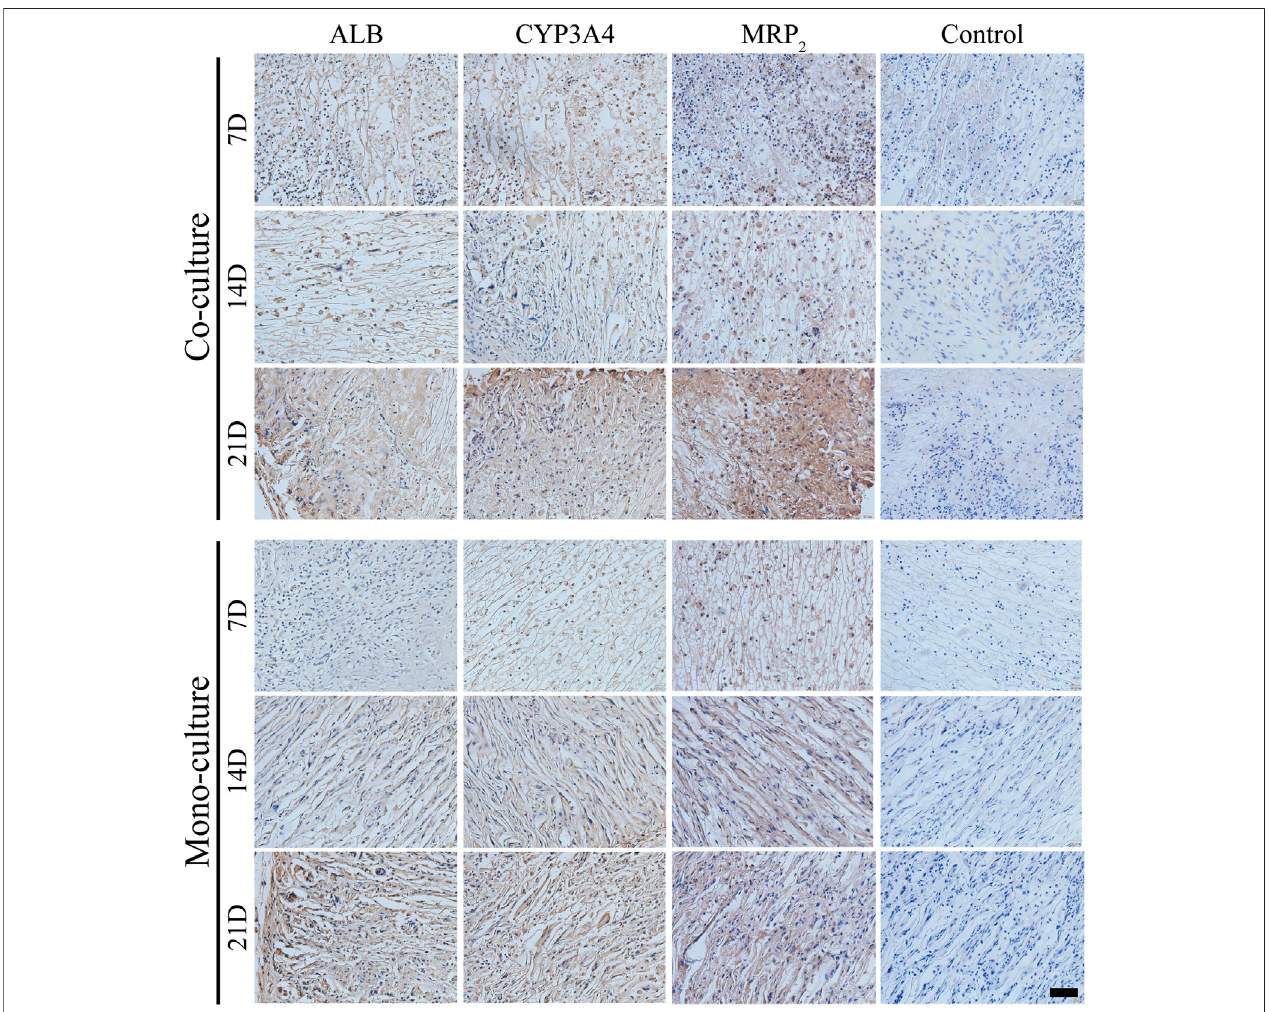
FIGURE 10 | IHC detection of ALB, CYP3A4, and MRP 2 expression in both groups after transplantation. Protein expressions increased gradually over time. Compared with monocultures, the co-culture group showed upregulated expressions at each time point. Scale bar, 50 µm.